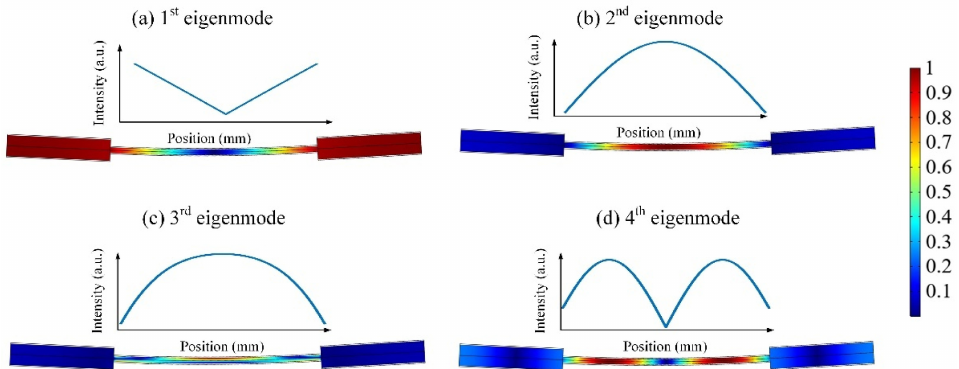
Figure 6. Calculated acoustic distribution within the photoacoustic resonator: ( a ) The 1st eigenmode at 2735 Hz; ( b ) the 2nd eigenmode at 16,787 Hz; ( c ) the 3rd eigenmode at 19,715 Hz; ( d ) the 4th eigenmode at 31,044 Hz.